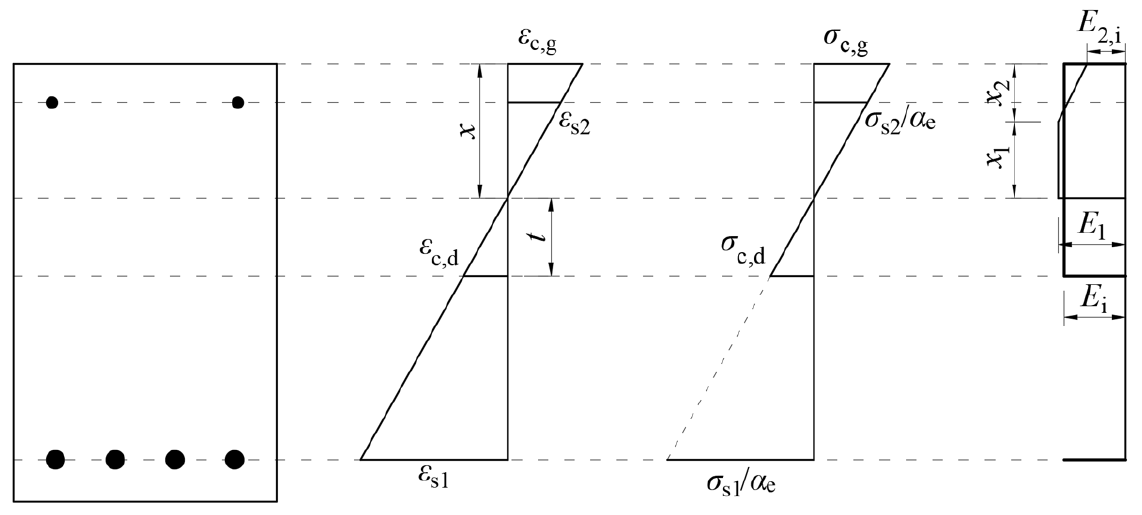
Figure 22: Normal strain, normal stress (for equivalent cross section) and Young’s modulus of concrete in cross section of given beam